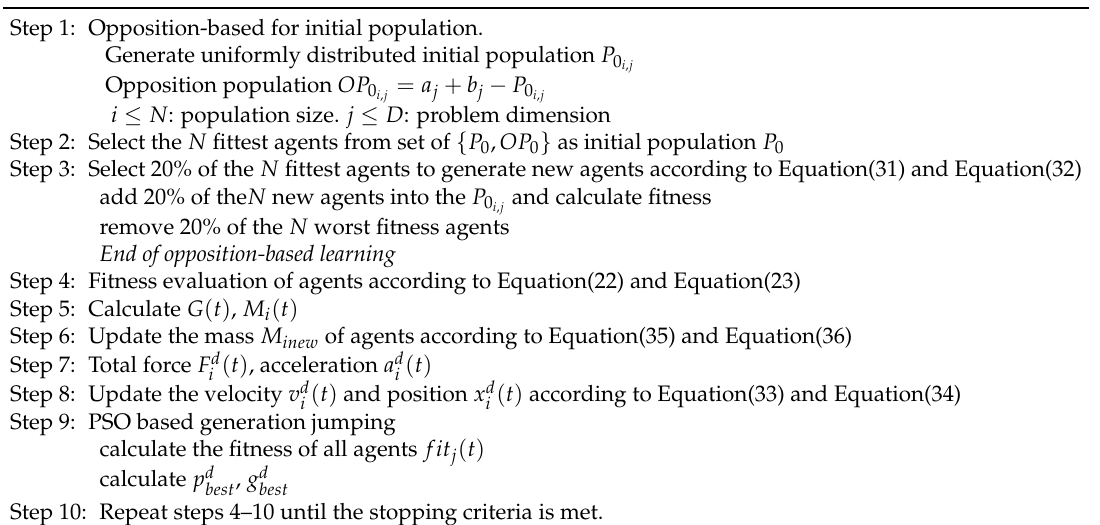
Table 1. Flowchart of